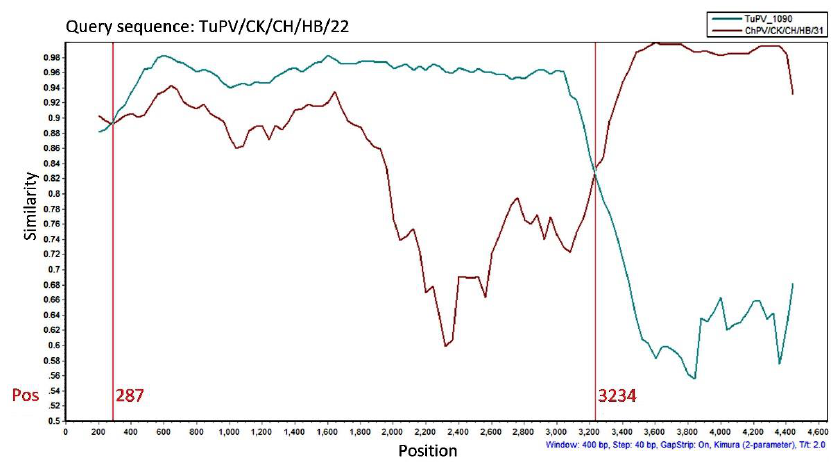
Figure 2. SimPlot analysis of recombinant TuPV/CK/CH/HB/22 sequence for confirming recombi- nation was performed using the Simplot software program v3.5.1. The analysis considered different parent sequences (strain TuPV-1090, TuPV/CK/CH/HB/31) plotted in a graph considering the vertical-axis percentage of permuted trees, and on the horizontal axis is the position on the genome of the query sequence.